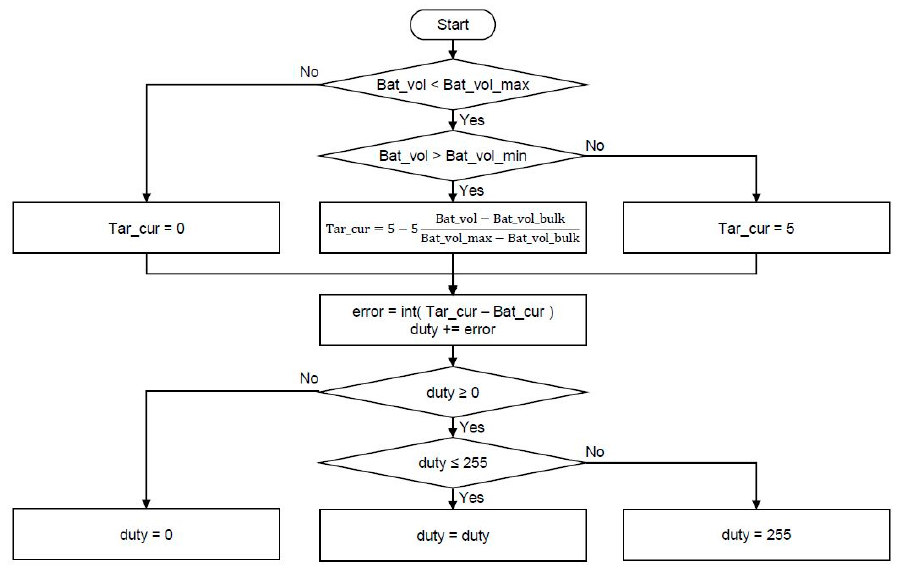
Figure 6. The software of the photovoltaic power management system.